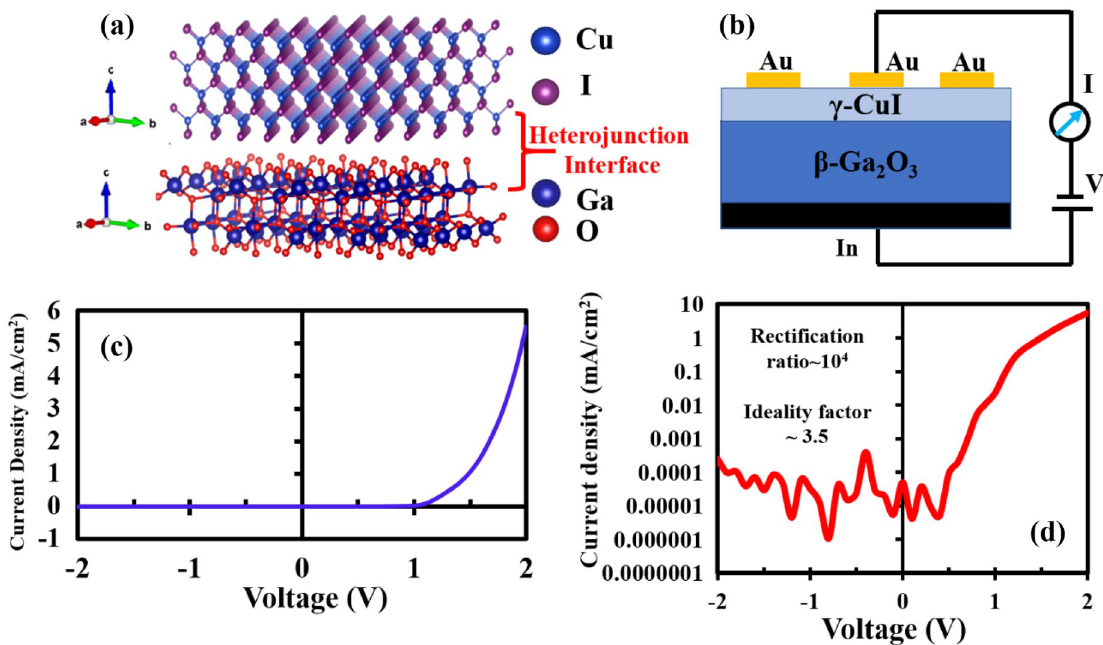
Fig. 2 a cross-section stick and ball crystal structure of γ-CuI and β-Ga γ-CuI and β-Ga